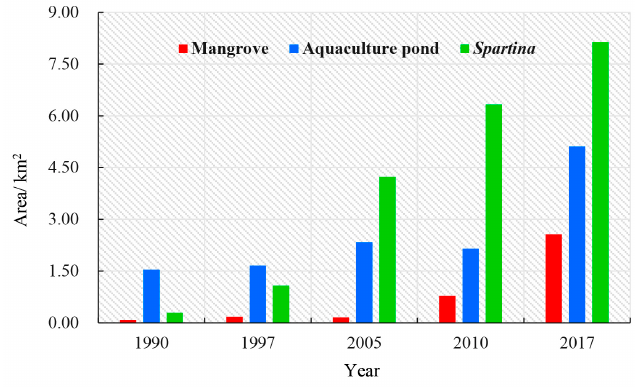
Figure 5. Change in total area of Mangrove, aquaculture pond and Spartina from 1990 to 2017. The Sankey diagram visualizes the dynamics of total land cover types from 1990 to 2017 (Figure 6a). The results show that mudflats were the principal land cover type invaded by Spartina . The area of Spartina expansion in mudflats was 65.98, 334.08, 305.45 and 412.37 ha during 1990–1997, 1997–2005, 2005–2010, and 2010–2017, respectively, which suggests an increase over time. However, the annual expansion rate for Spartina was 20.66%, 18.61%, 8.40% and 3.64% during 1990–1997, 1997–2005, 2005–2010, and 2010–2017, respectively, suggesting a progressive decline.